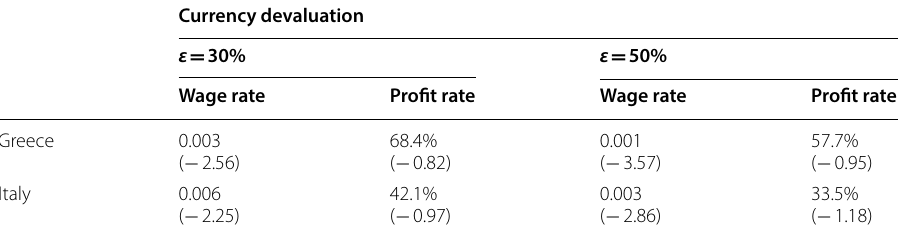
Table 11 The long-run effects of currency devaluation on the wage and profit rates; Greece and